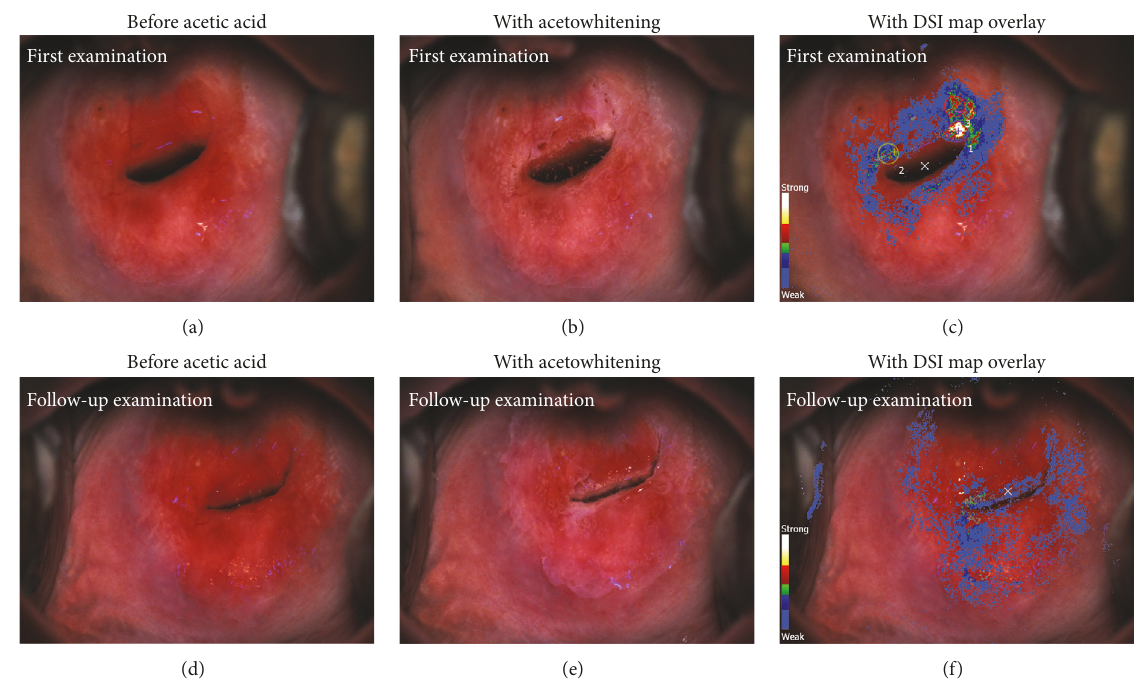
Figure 1: (a, b, and c) First examination. (a) Cervical appearance prior to application of acetic acid. (b) Cervical appearance after application of acetic acid. (c) DSI map overlaid on the cervix. Strong acetowhitening signal suggested potential high-grade lesion as identified by the DSI technology (colour legend on the left). The circular annotations are the biopsy sites selected and indicated during the examination; number 1 was identified by the colposcopist; numbers 2 and 3 were marked using the DSI map. (d, e, and f) Follow-up examination. (d) Cervical appearance prior to application of acetic acid. (e) Cervical colposcopic appearances after application of acetic acid. No significant acetowhitening effect is observed. (f) DSI map overlaid on the cervix, confirming the absence of significant changes. Notably, the area that yielded CIN2 at the first visit, now appears normal.